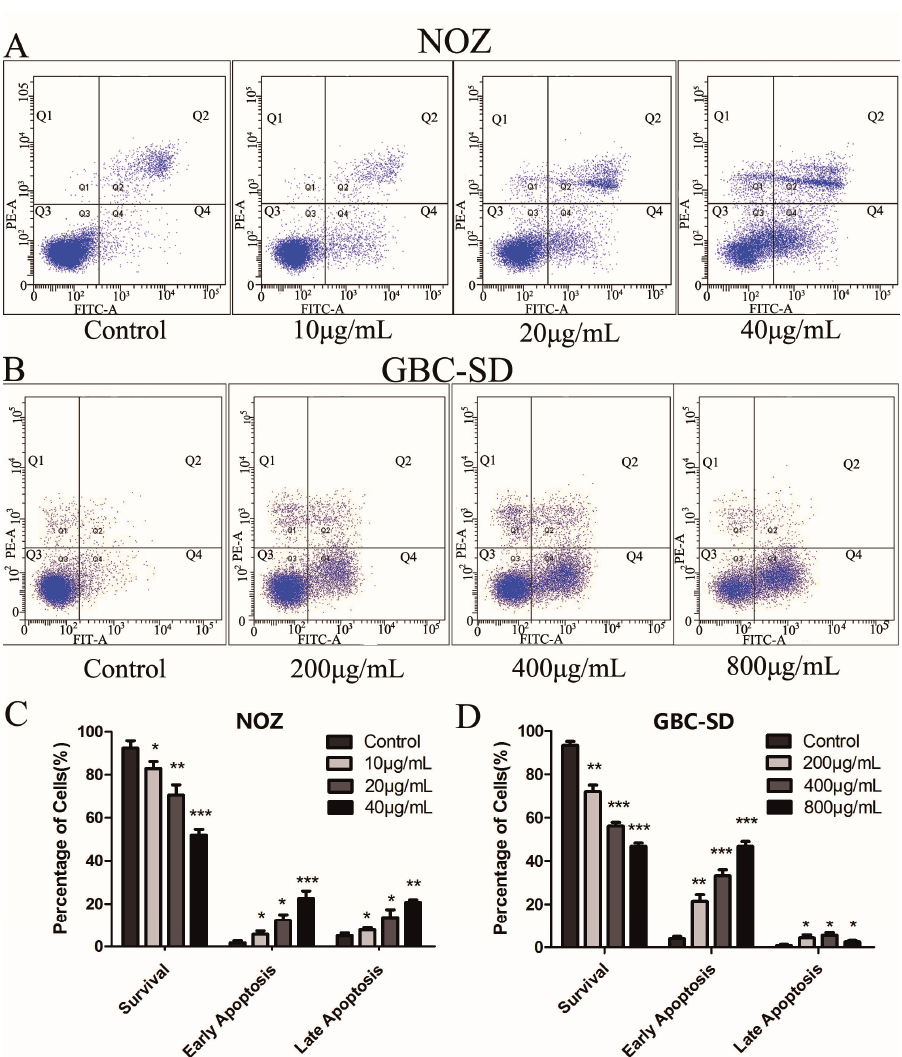
Figure 4. Cordycepin induces the apoptosis of human gallbladder cancer